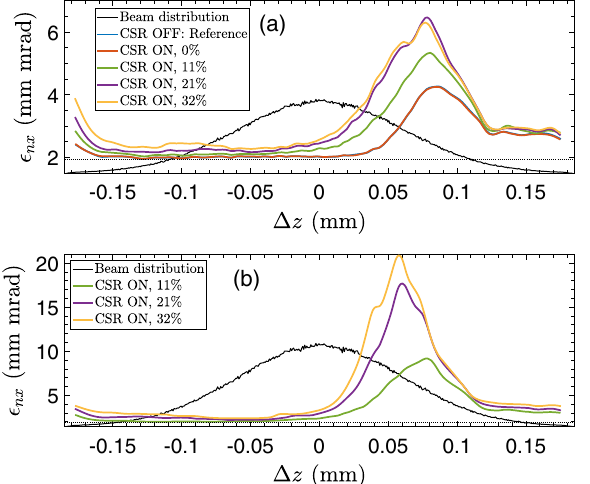
FIG. 23. Slice emittance along the electron beam after propa- gation through 5 m plasma source. (a) Cases where the beam centroid and angle are not adjusted. (b) Cases where those are adjusted. Black solid and dashed lines indicate the longitudinal electron beam distribution in arbitrary units and initial emittance of 1.936 mm mrad, respectively. Electron beam head is placed at positive Δ z , whereas the tail at negative Δ z .